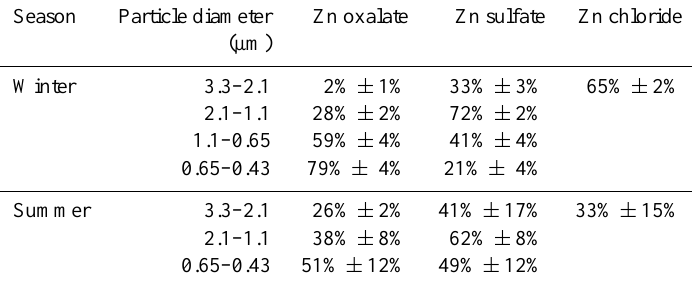
Table 4. Fraction of various Zn species at Tsukuba in the winter and summer determined by EXAFS fitting (mol%). Season Particle diameter Zn oxalate Zn